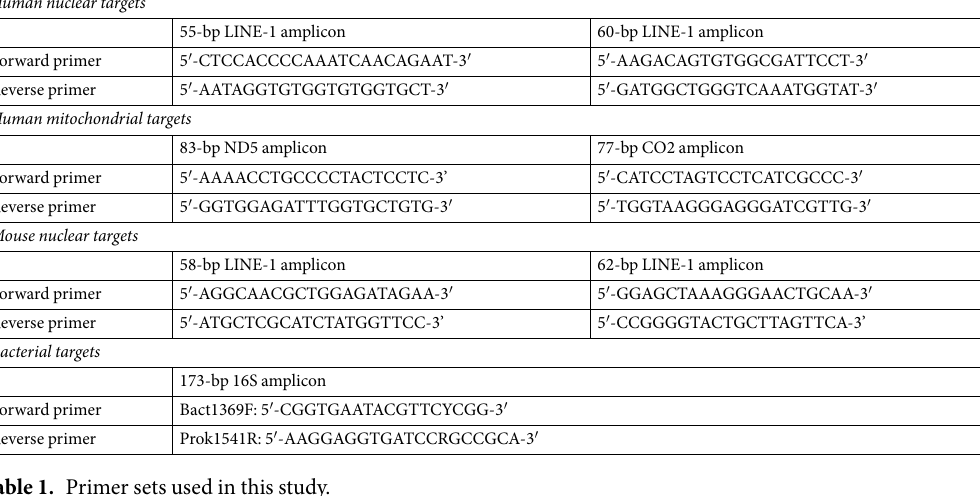
Table 1. Primer sets used in this